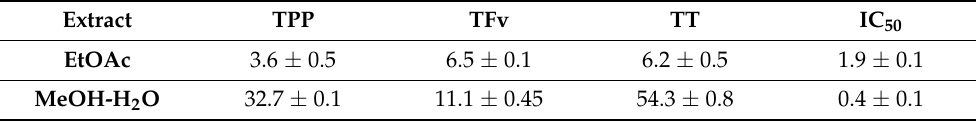
Table 3. TPP, TFv and TT content in C. humilis solvent